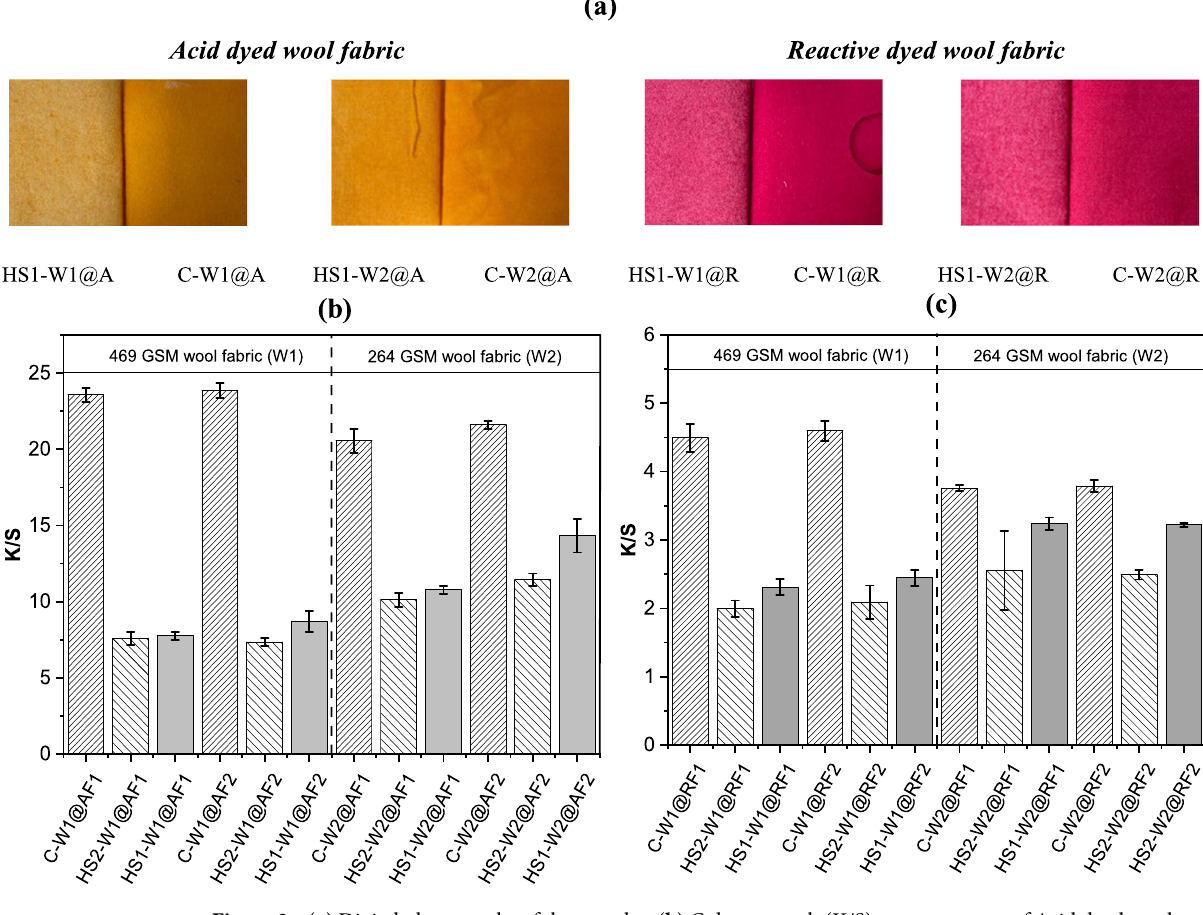
Figure 2. ( a ) Digital photographs of the samples; ( b ) Color strength (K/S) measurements of Acid dyed wool fabric; ( c ) Color strength (K/S) measurements of reactive dyed wool fabric ( = Conventional; = Two- steps HS method; = One-step HS